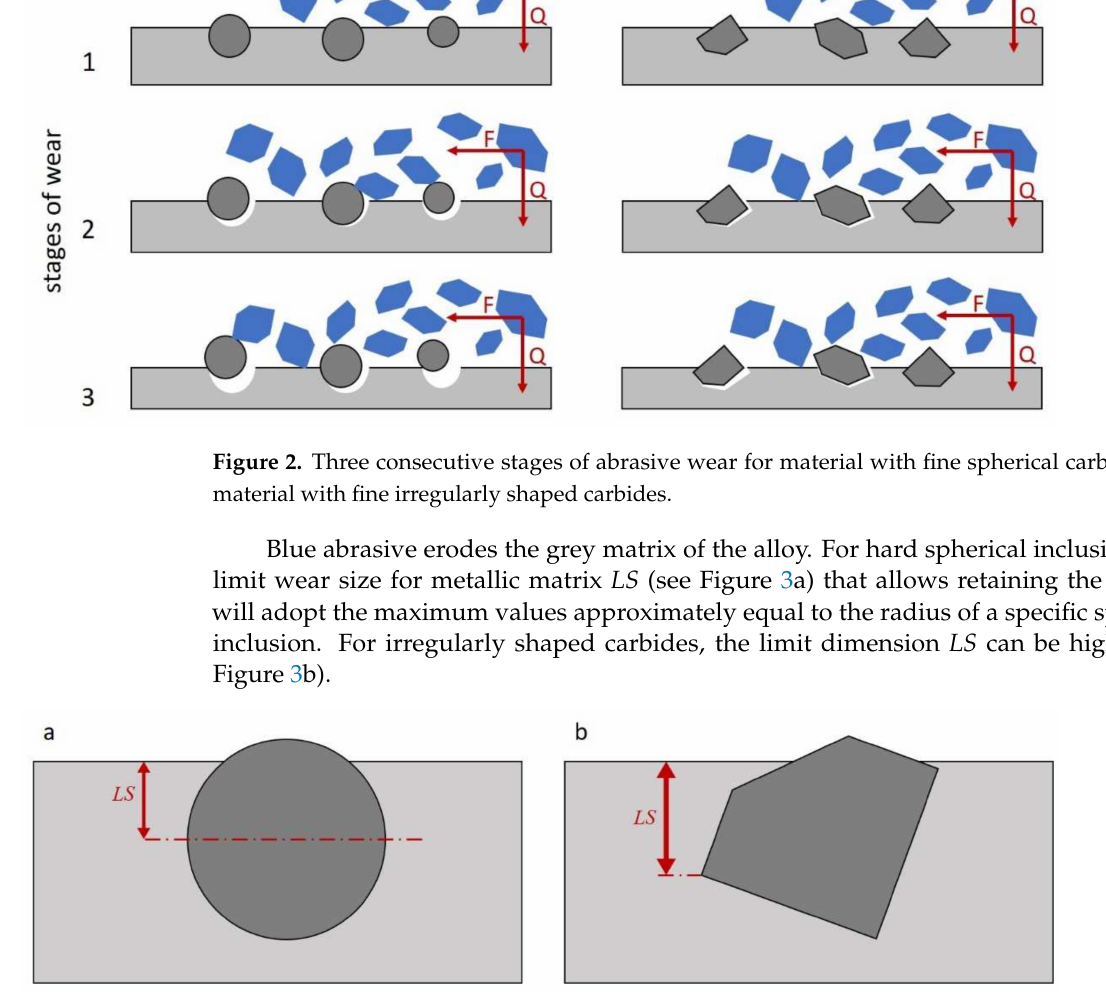
Figure 3. Matrix wear limit size LS allowing for maintaining the particle: ( a ) spherical one; ( b ) exam- ple irregular